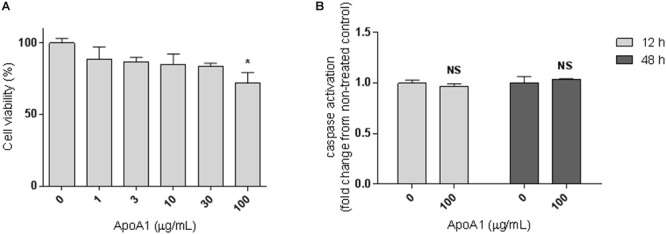
ApoA1 decreases the viability of ovarian cancer cells without affecting caspase activation. (A) SKOV3 cells were incubated with human ApoA1 up to a concentration of 100 μg/mL in serum-free conditions for 48 h. Untreated cells were exposed to vehicle only. ApoA1 treatment significantly decreased the viability of SKOV3 cells (Kruskal–Wallis test with Dunn’s multiple comparison post-test; p < 0.05). (B) SKOV3 cells were incubated with 100 μg/mL ApoA1 for 12 h (light gray bars) and 48 h (dark gray bars). Caspase 3/7 activation was quantified and normalized to the number of viable cells. No differences were observed in caspase activation between untreated cells and cells exposed to ApoA1. Differences were considered significant if p < 0.05. ∗p < 0.05.